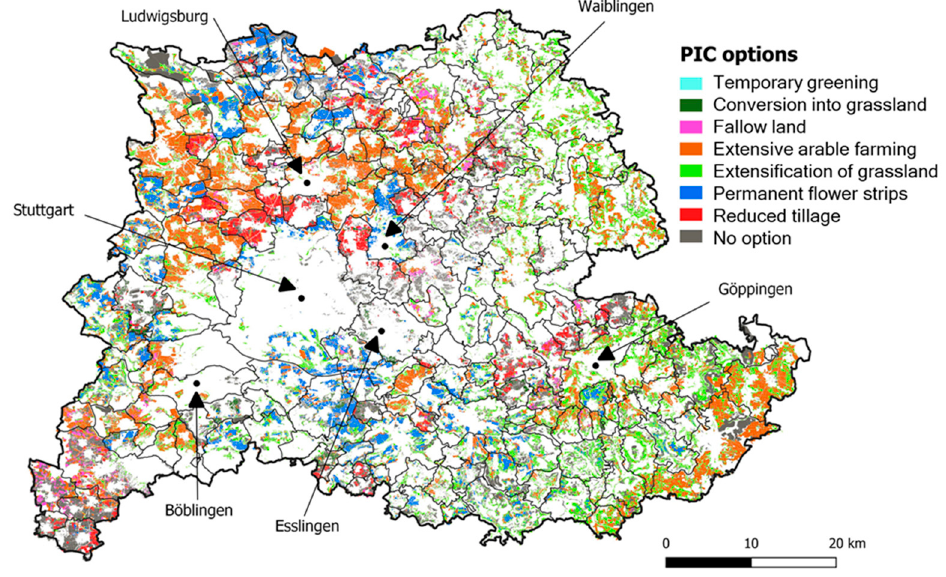
Figure 5. PIC map from the nature conservation perspective showing the priority option based on IACS data and BKG [36]